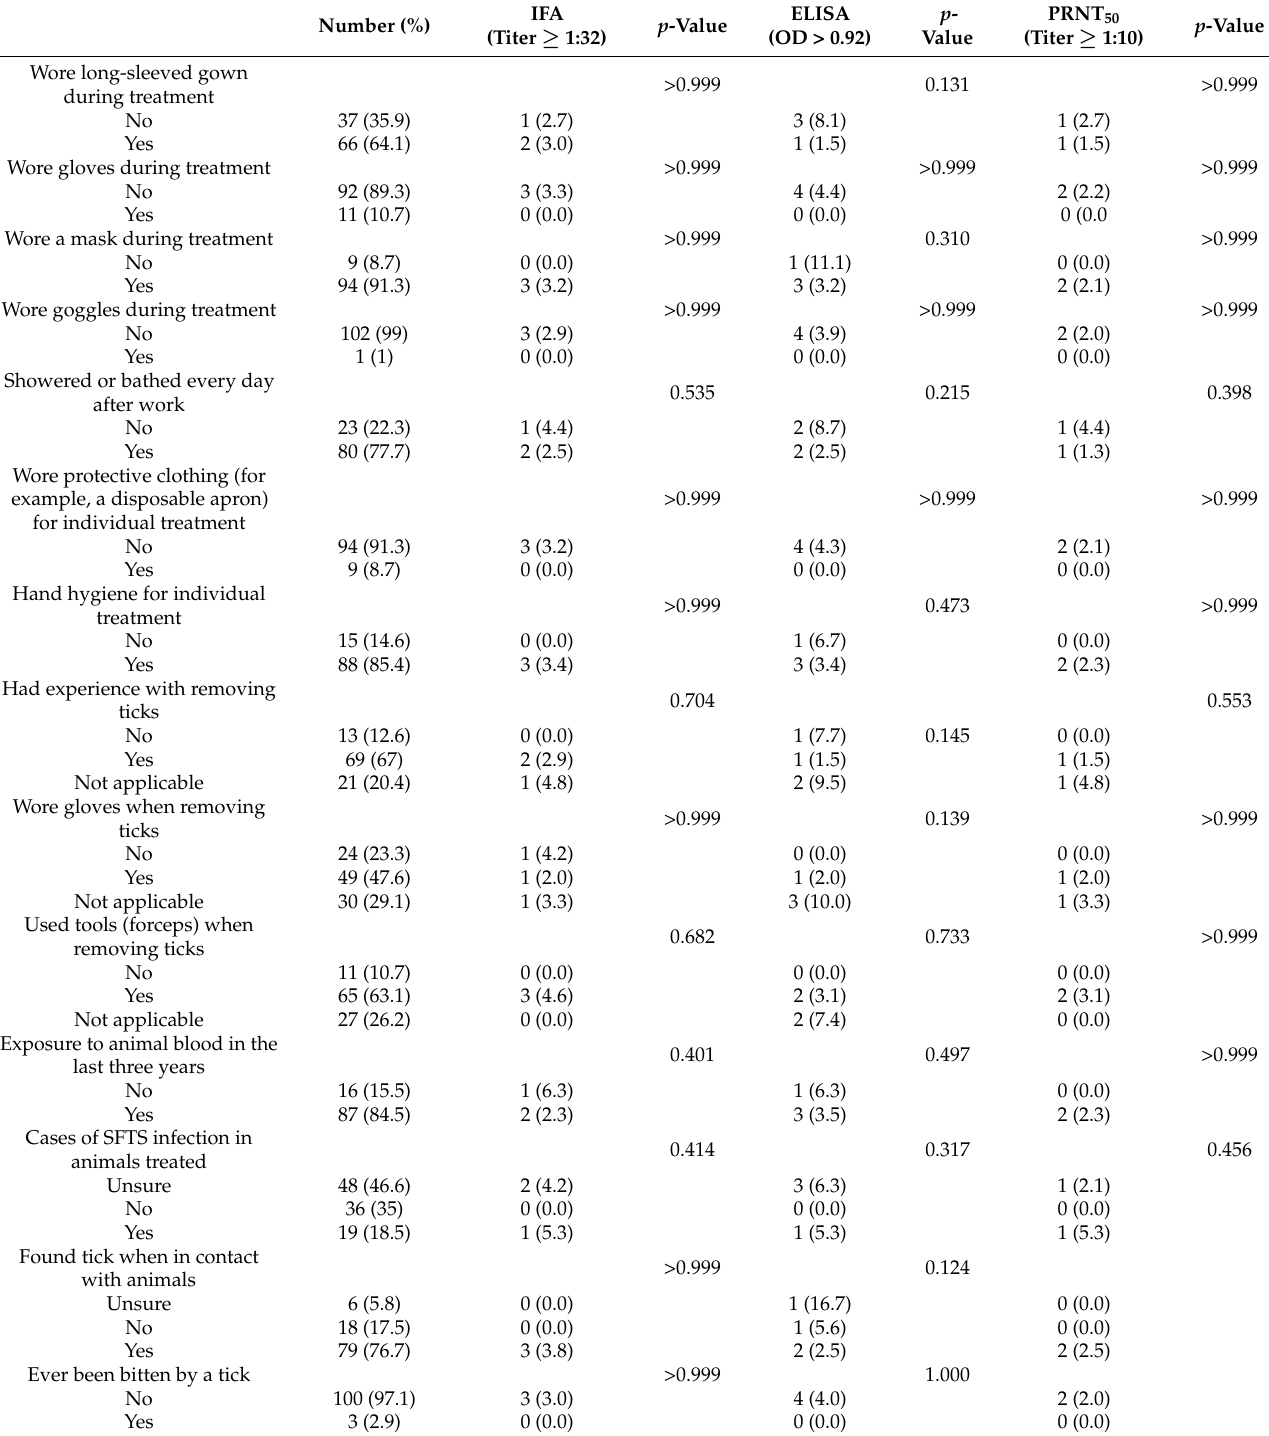
Table 5. SFTS seroprevalence according to preventive behaviors during treatment and exposure